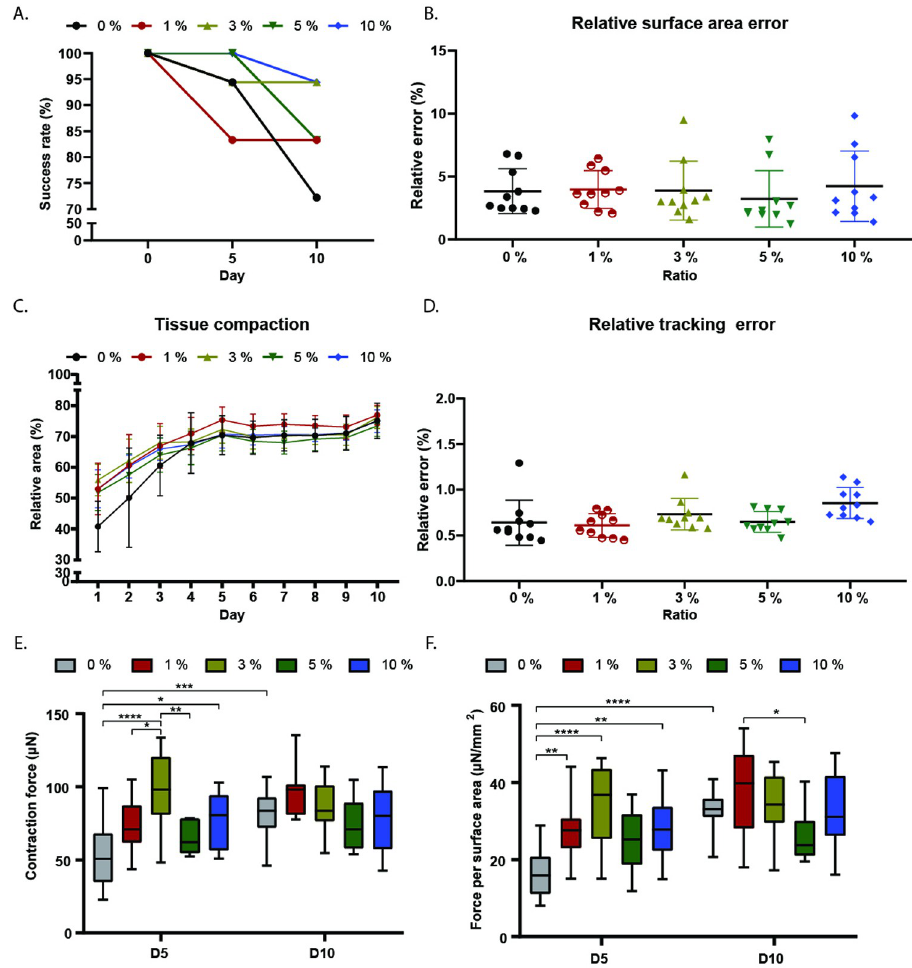
Fig 6. EHT comparison with different ratio of Human adult cardiac fibroblast (HCF). (A) Success rate of tissue formation using different ratio of HCF. (B) Relative surface area error by comparing the tissue area measured manually using Image J and using the stand alone application. (C) Relative tissue compaction by comparing the initial tissue area at day 0 (10.7 mm 2 ) with the tissue area over time with the different ratio of HCF. (D) Relative tracking error of the pillar’s center by comparing the distance measured manually using Image J and using the stand alone application. (E) Contractile force of EHTs with different ratios of HCF at day 5 and 10. (F) Contractile force of EHTs with different ratios of HCF divided by the surface are of the tissue at day 5 and 10. In E-F, data shown as means, maxima and minima; Two-way ANOVA plus Tukey’s test for comparisons among ratios of HCF; � = p < 0.05; �� = p < 0.01; ��� = p < 0.001; ���� = p < 0.0001,(N =